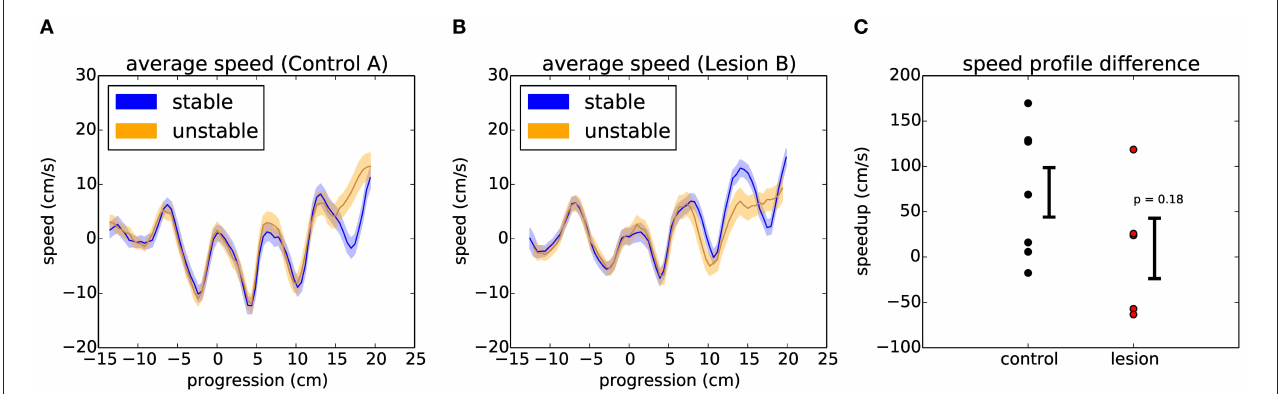
FIGURE9 Encountering different states of the randomized obstacles causes the animals to quickly adjust their movement trajectory. (A) Example average speed profile across the obstacles for stable (blue) and unstable (orange) trials in the randomized sessions of a control animal (see text). The shaded area around each line represents the 95% confidence interval. (B) Respectively for one of the largest lesions. (C) Summary of the average difference between the speed profiles for stable and unstable trials across the two groups of animals. Error bars show standard error of the mean. p value from Student’s unpaired t-test is